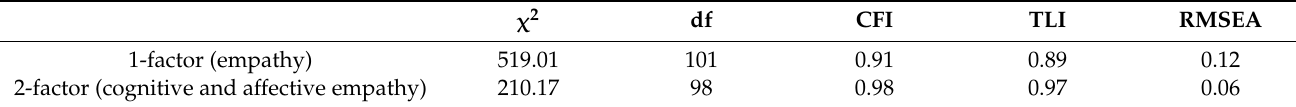
Table 2. Confirmatory factor analysis (CFA) results for the empathy